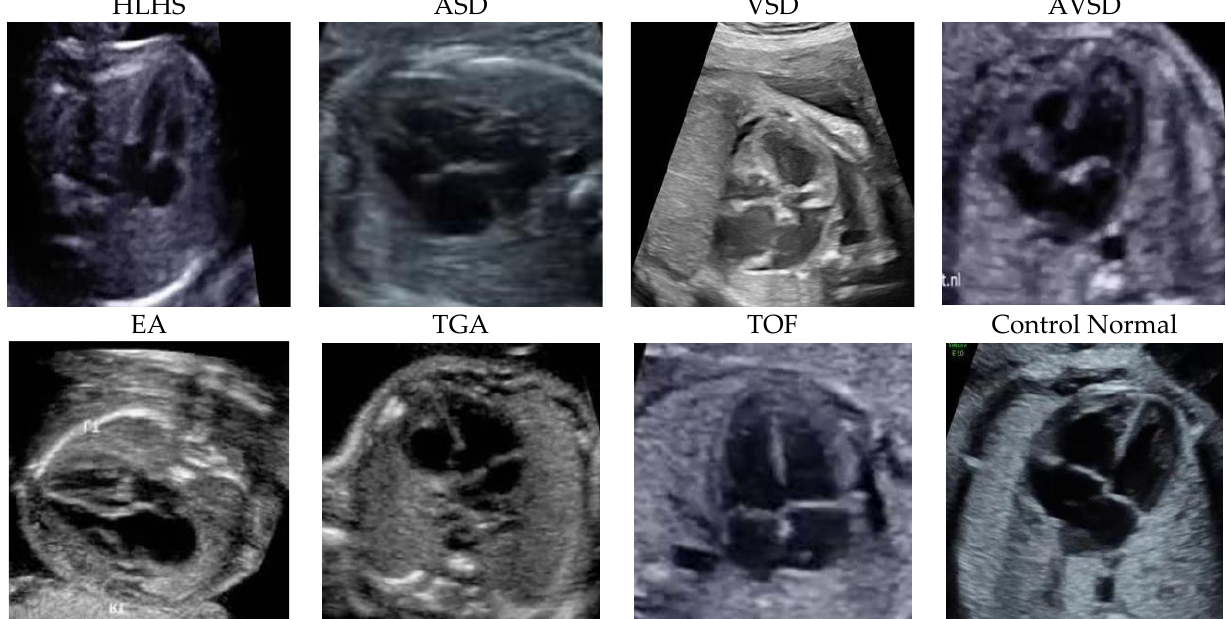
Figure 1. The samples were fetal heart images with seven diseases and a normal control. The entire patient was collected from Mohammad Hoesin General Hospital, Palembang. Indonesia.